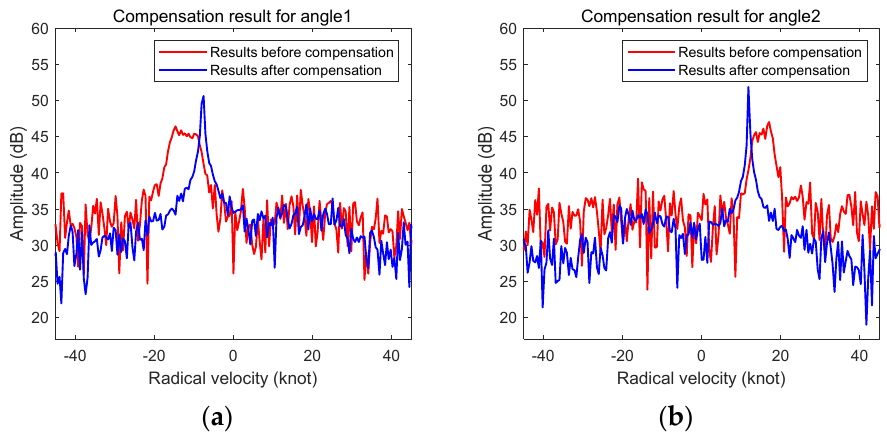
odic yaw motion and corresponding space–time two-dimensional spectra before and after motion compensation.